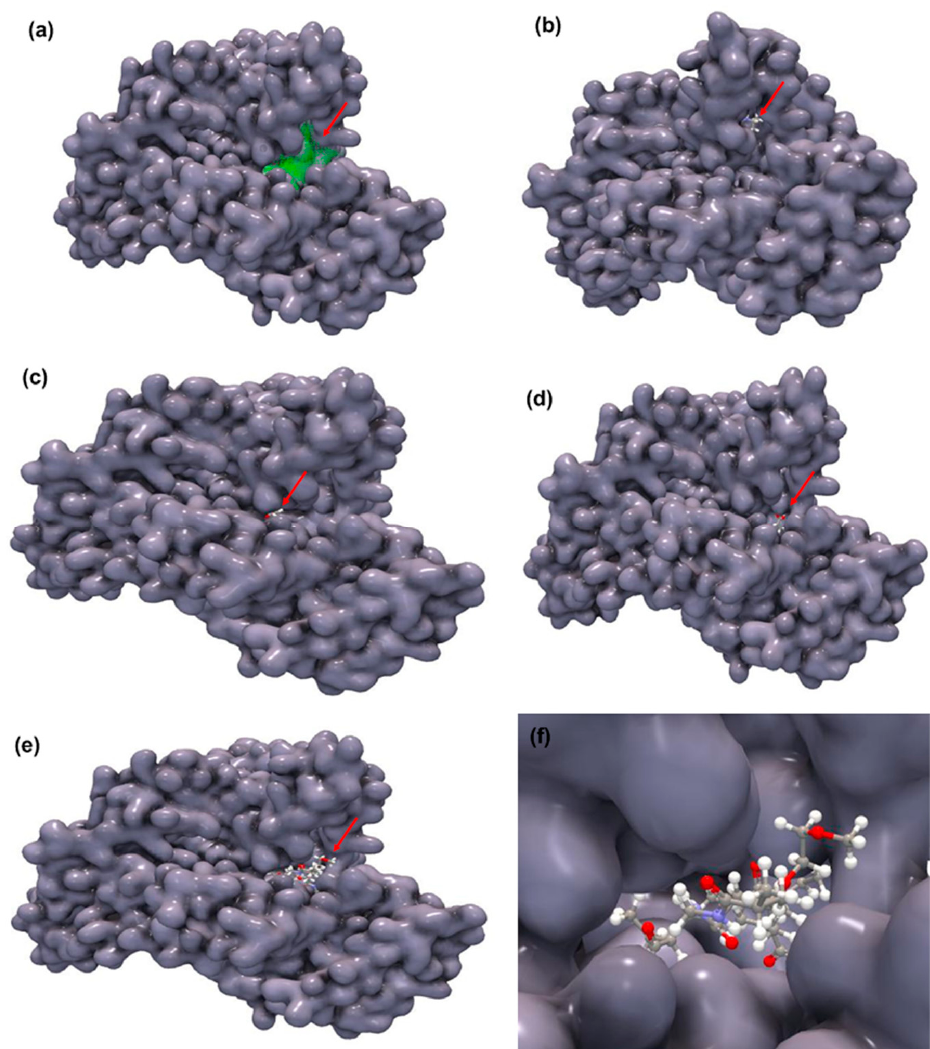
Figure 5. Molecular docking snapshots of the potential binding sites of BSA ( a ); interactions of NIPAM with BSA ( b ); interactions of PEGMA with BSA ( c ); interactions of AA with BSA ( d ); interactions of copolymer with BSA ( e ); and the magnified images for interactions of the copolymer with the largest binding pocket of the BSA ( f ). The red arrow indicates the position of the monomer or copolymer in the protein. Table 1. Docking score and hydrogen bond (H-bond) score for the interaction of the copolymer, PEGMA, NIPAM and AA with the best selected docking position of BSA. Molecular dimensions of the binding sites